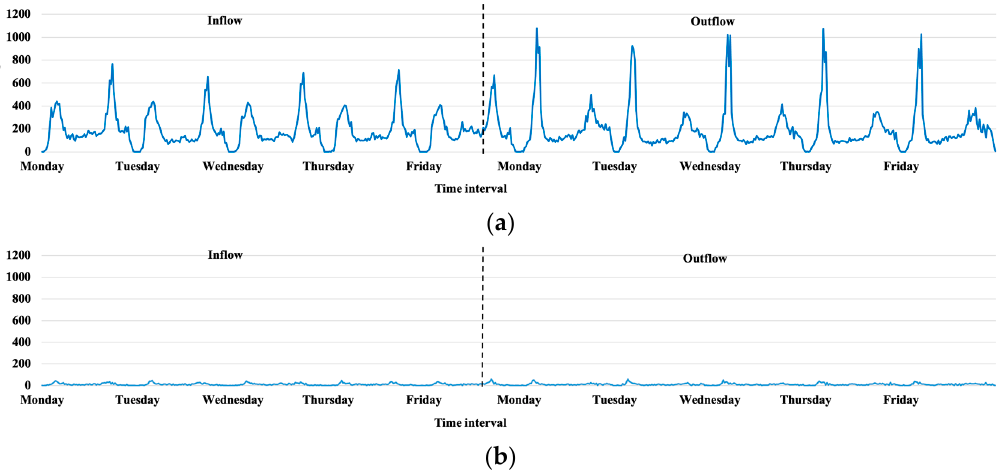
Figure 1. Inflow and outflow at the two stations in the Xiamen BRT. ( a ) Xianhou Station; ( b ) Dongzhai